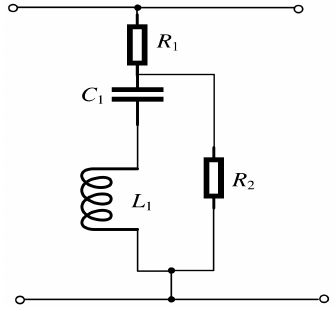
Figure 1. Negative group delay